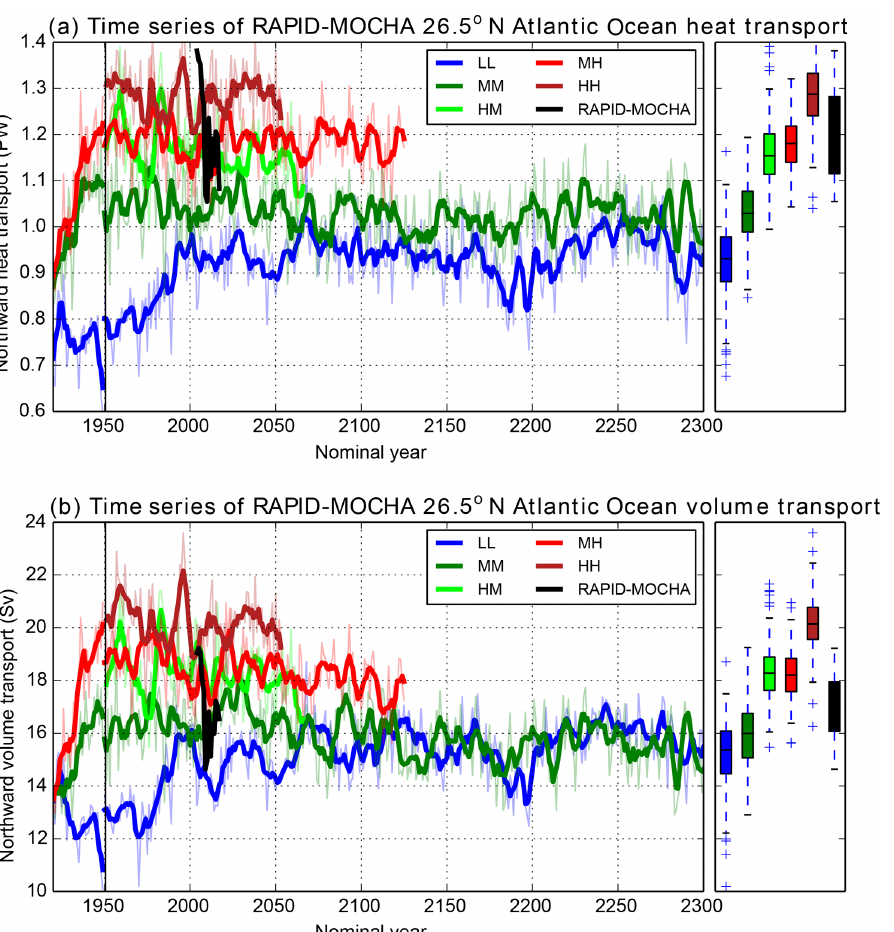
Figure 14. (a) Time series of annual mean (January–December) Atlantic northward ocean heat transport at 26.5 ◦ N calculated consistently with the RAPID-MOCHA array using the RapidMoc code (C. D. Roberts, 2017). (b) As above but for volume transport, i.e. the Atlantic meridional overturning circulation at 26.5 ◦ N and 1000m depth, with net transport across sections subtracted. Different model resolutions over the spinup-1950 and control-1950 simulations are shown together with the RAPID-MOCHA observations in black. The thick line shows a 5-year running mean of the annual values (thinner lines). A box-and-whisker plot on the right (using the control-1950 data) shows the lower to upper quartile range as the coloured box; the median (black line within that box) and the whiskers show the range of the data (excluding flier points shown by the +